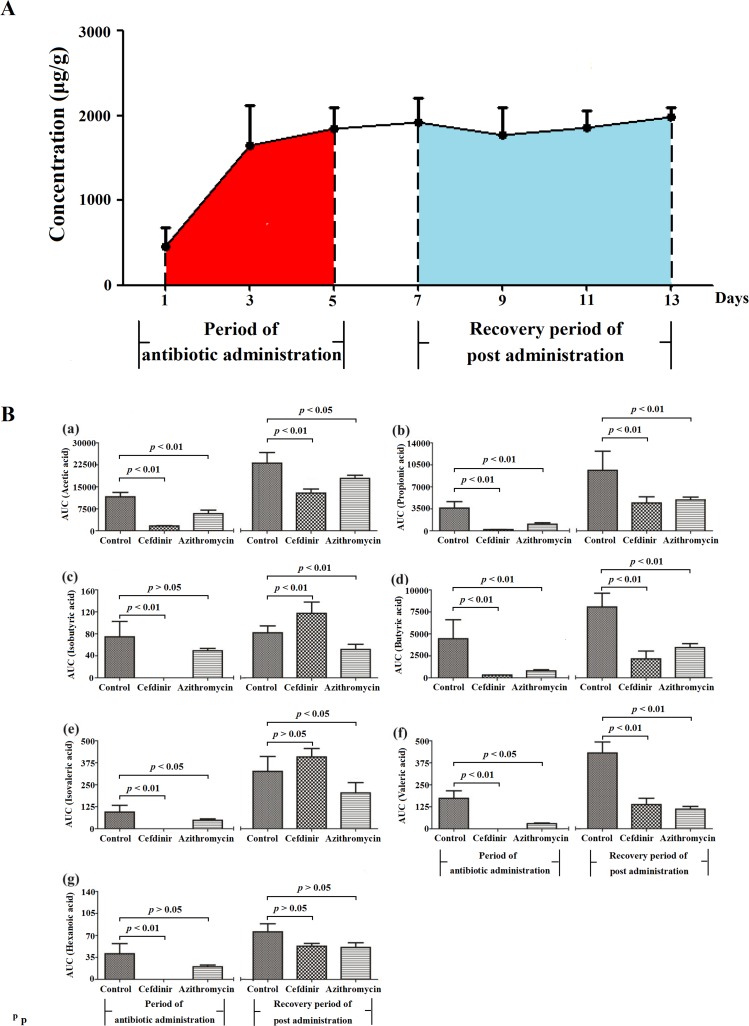
The schematic diagram of AUC with a function of time (A), and AUC of SCFAs in fecal samples in the periods of antibiotic-treated and recovery (B). (a) acetic acid; (b) propionic acid; (c) isobutyric acid; (d) butyric acid; (e) isovaleric acid; (f) valeric acid; (g) hexanoic acid.